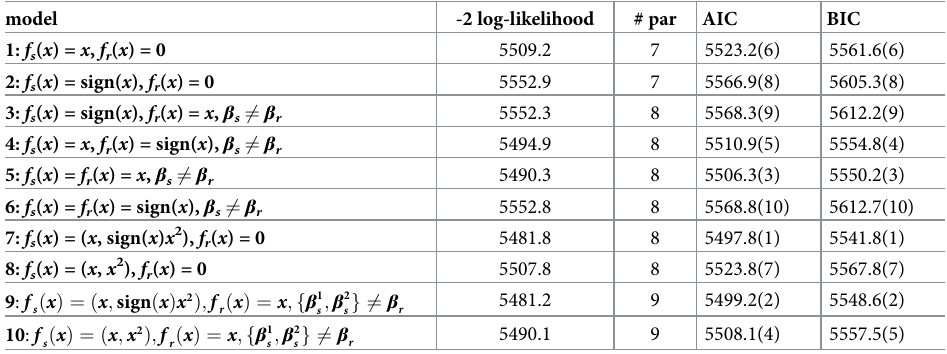
We proposed the use of a new multicategory logit model for estimating and modelling the dis- crete MIC distributions over time. Not modelling the underlying continuous distribution avoids Table 7. The ISU VDL data: Summary goodness-of-fitted of all fitted